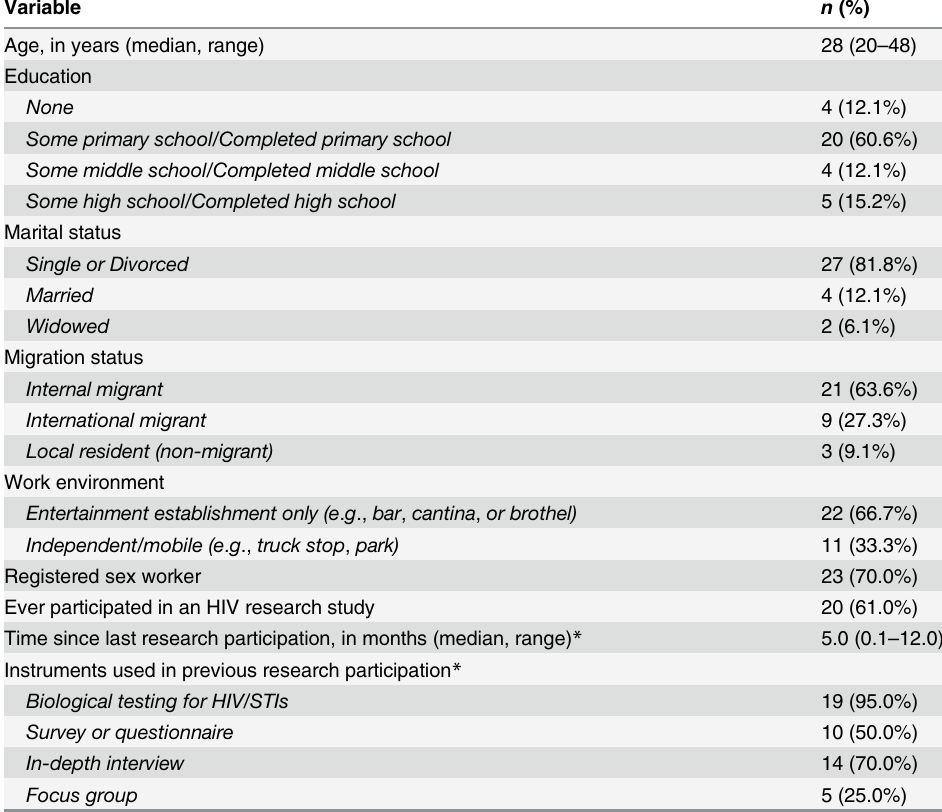
Table 1. Characteristics of participating female sex workers ( N = 33), Tecún Umán, Guatemala, 2013 – 2014. Variable n (%) Age, in years (median,